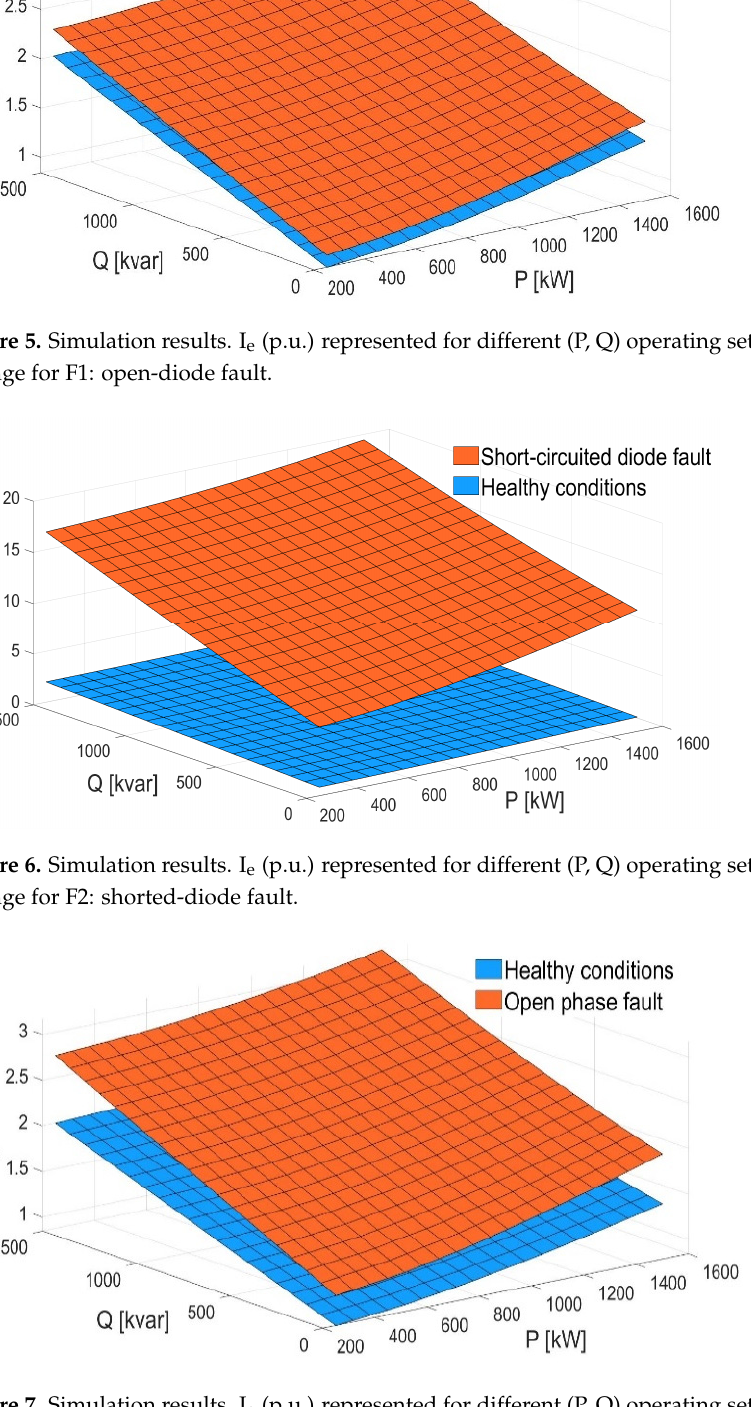
Figure 7. Simulation results. I e (p.u.) represented for different (P, Q) operating setpoints at reference voltage for F3: exciter open-phase fault.